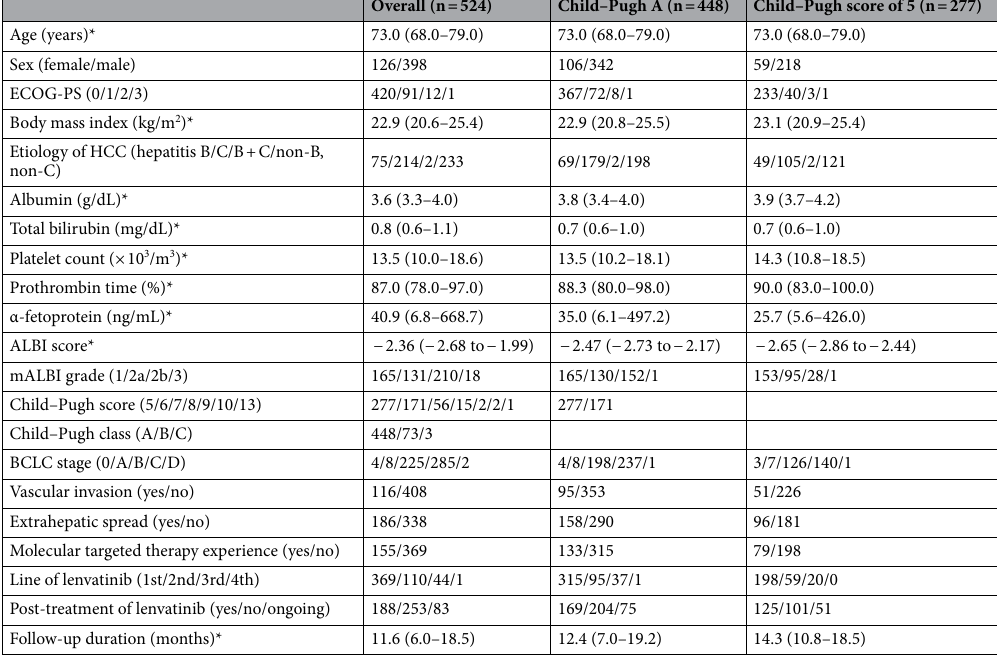
Table 1. Patient characteristics. *Values are expressed as medians (interquartile range). ECOG-PS Eastern Cooperative Oncology Group performance status, HCC Hepatocellular carcinoma, ALBI Albumin–bilirubin, mALBI Modified albumin–bilirubin, BCLC Barcelona clinic liver